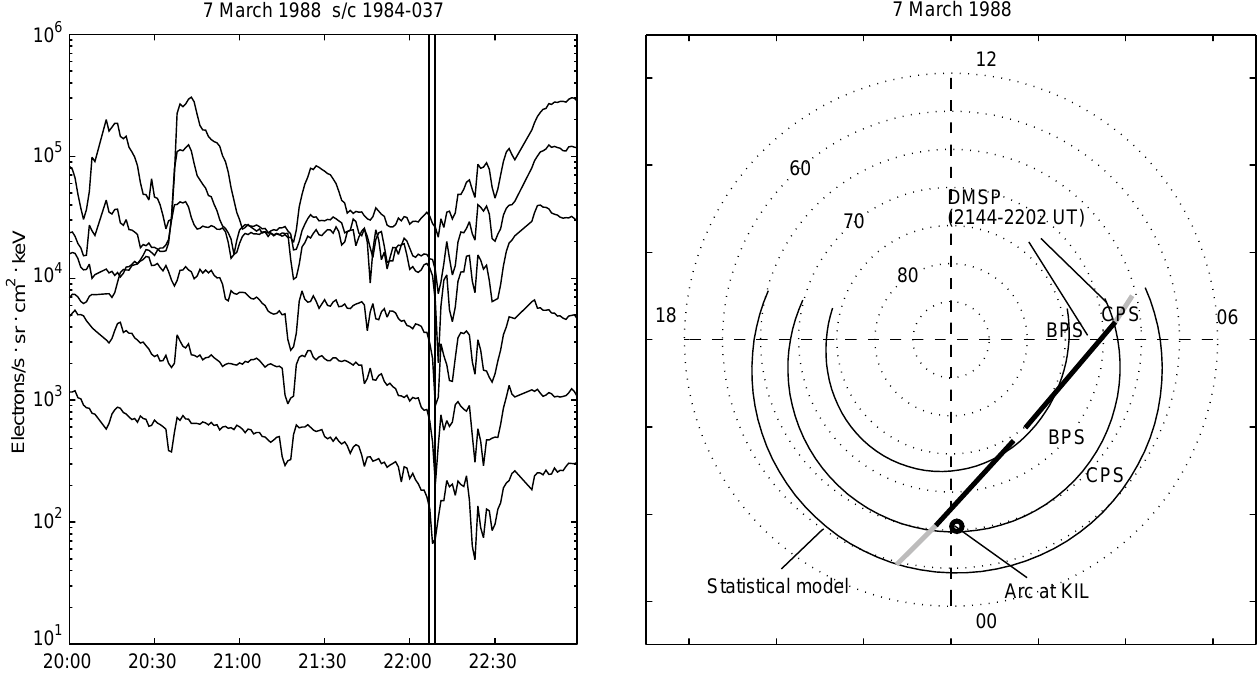
statistical models for the CPS and BPS precipitation regimes (for more details, see text). The gray and black heavy solid lines show the CPS and BPS regimes, respectively, as recorded by DMSP F9 (2144– 2202 UT), and the thin solid lines show the statistical boundaries. The location of the fading arc at KIL is marked with a